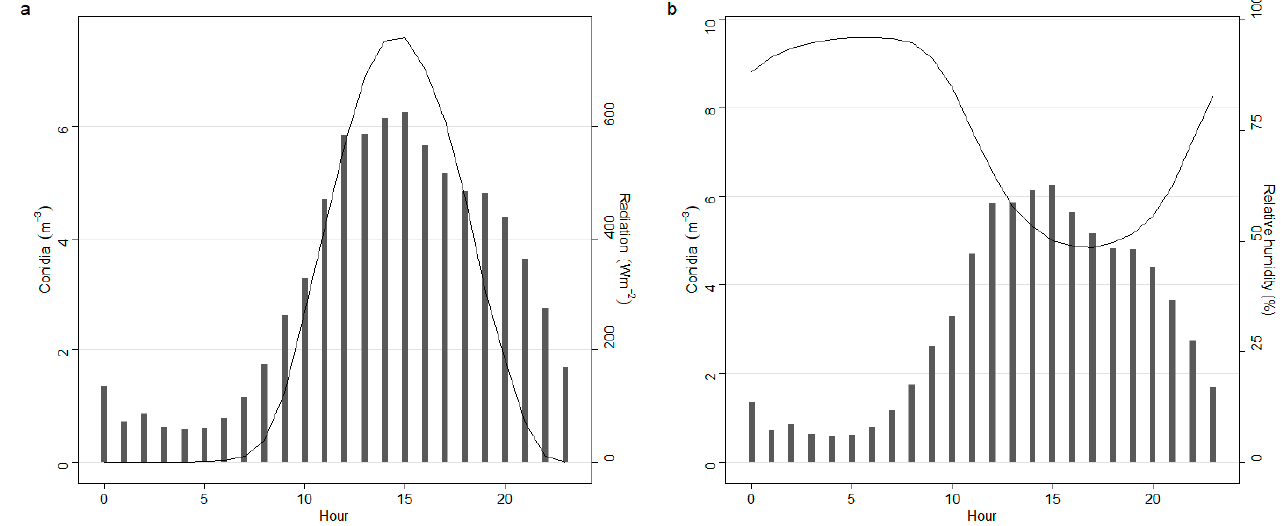
Figure 7. Intra-diurnal variations among Alternaria conidia and the most influenced weather parame- ters, namely solar radiation (Radiation) ( a ) and relative humidity ( b ). Each bar represents each hour of 24 h in a